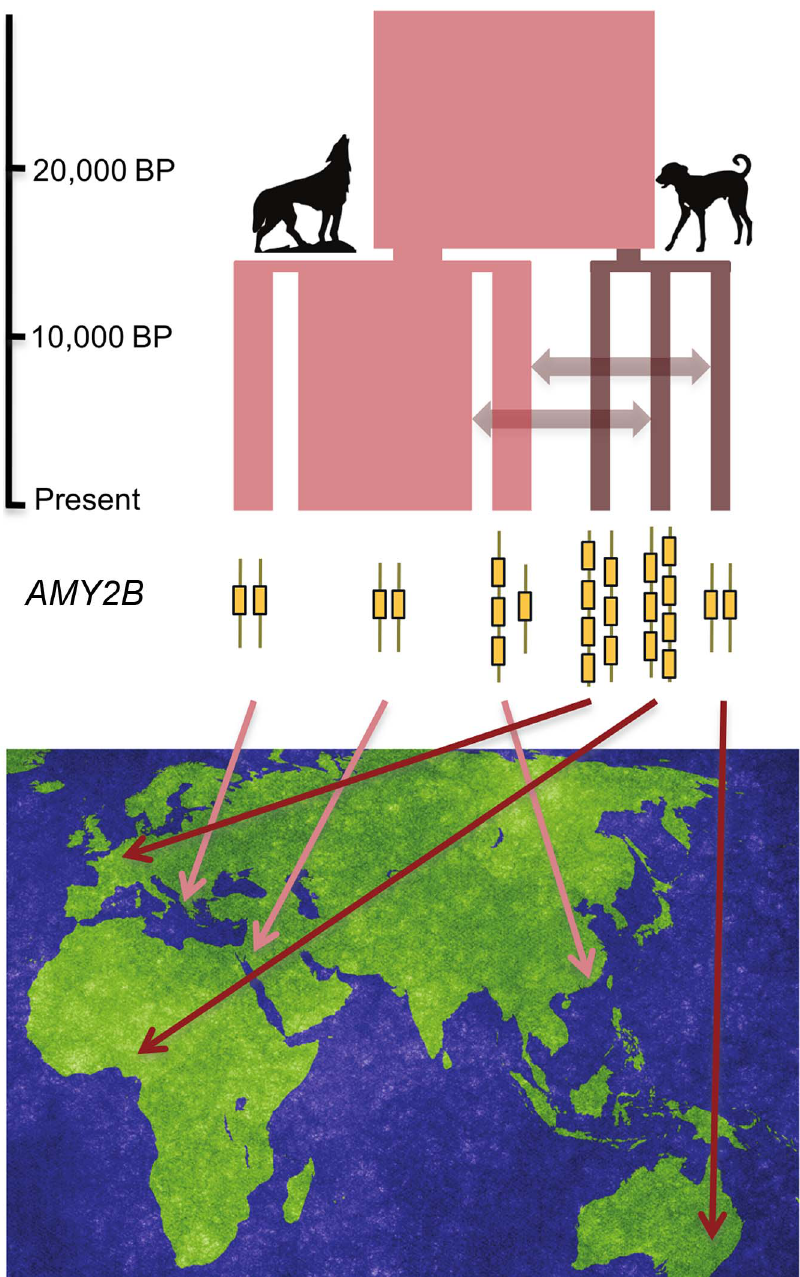
Figure 1. Summary of the demographic model and sampling from Freedman et al. [ 1 ] . Their criticalinclusion of data from theAustralian Dingo illustrates thathigh copy number in AMY2B is not a basal trait in dogs. The reciprocal monophyly of wild and domestic suggests that, despite thegeographical diversity of sampling, descendantsof the wolfpopulation thatcontributedto dog domestication are not represented and may only be accessible using ancient DNA.